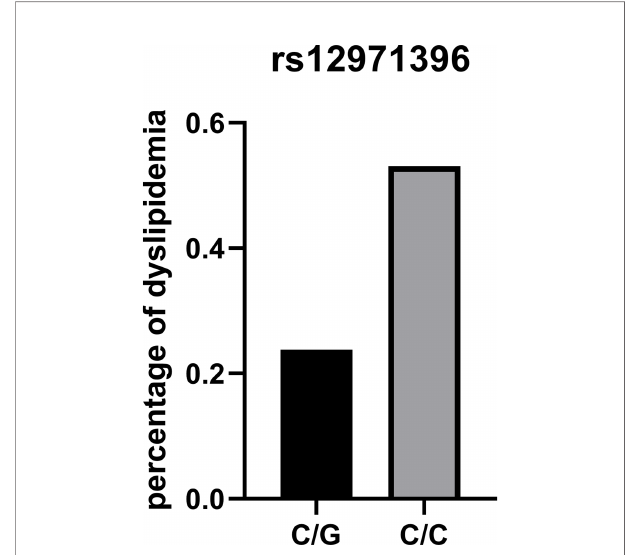
FIGURE 1 | Percentage of dyslipidemia in different genotypes of IFNL3